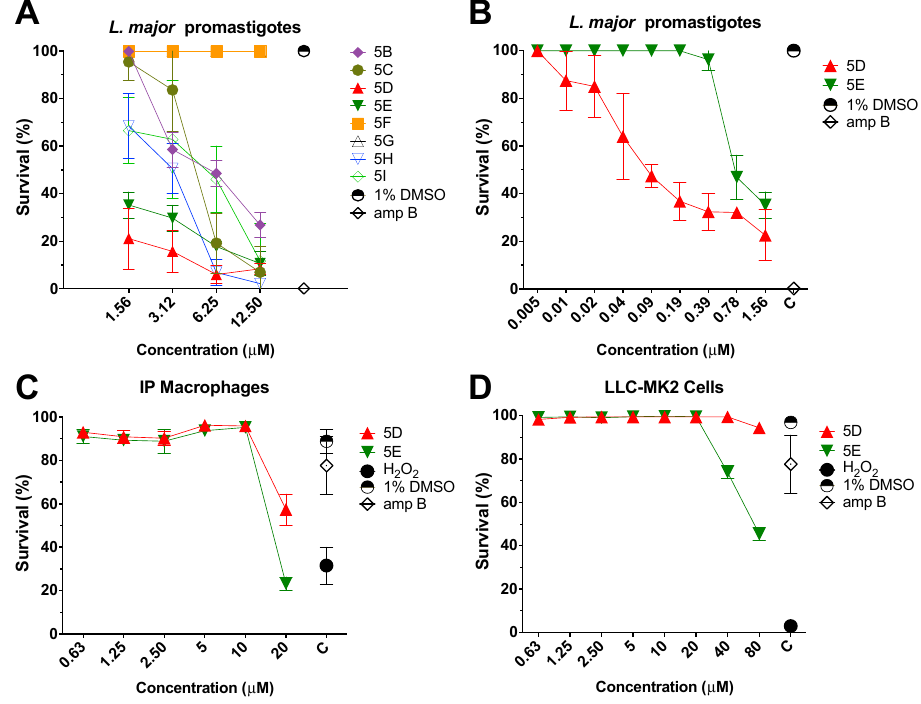
Figure 4. ( A ) Antiparasitic effect of the eight thiophene derivatives. Viability of L. major-luc promastigotes treated with the eight thiophene derivatives at a concentration of 1.56 to 12.5 µM for 72 h. ( B ) Evaluation of L. major-luc promastigotes treated with 5D or 5E thiophene derivatives at lower concentrations (0.005 to 1.56 µM) for 72 h. Controls treated with 1% DMSO, or amphotericin B (amp B) at 5 µM. ( C ) Cytotoxicity evaluation of intraperitoneal mouse macrophages (IP Φ ) treated with 5D or 5E thiophene derivatives at concentrations from 0.63 to 20 µM for 48 h. ( D ) Cytotoxicity evaluation of monkey kidney cells (LLC-MK2) treated with 5D or 5E thiophene derivatives at a concentrations from 0.63 to 80 µM for 72 h. Controls treated with 1% DMSO, amp B at 5 µM, or 5% of hydrogen peroxide (H 2 O 2 ). Cells were stained with Hoechst 33342 (healthy cell) and Propidium Iodide (compromised cell) .